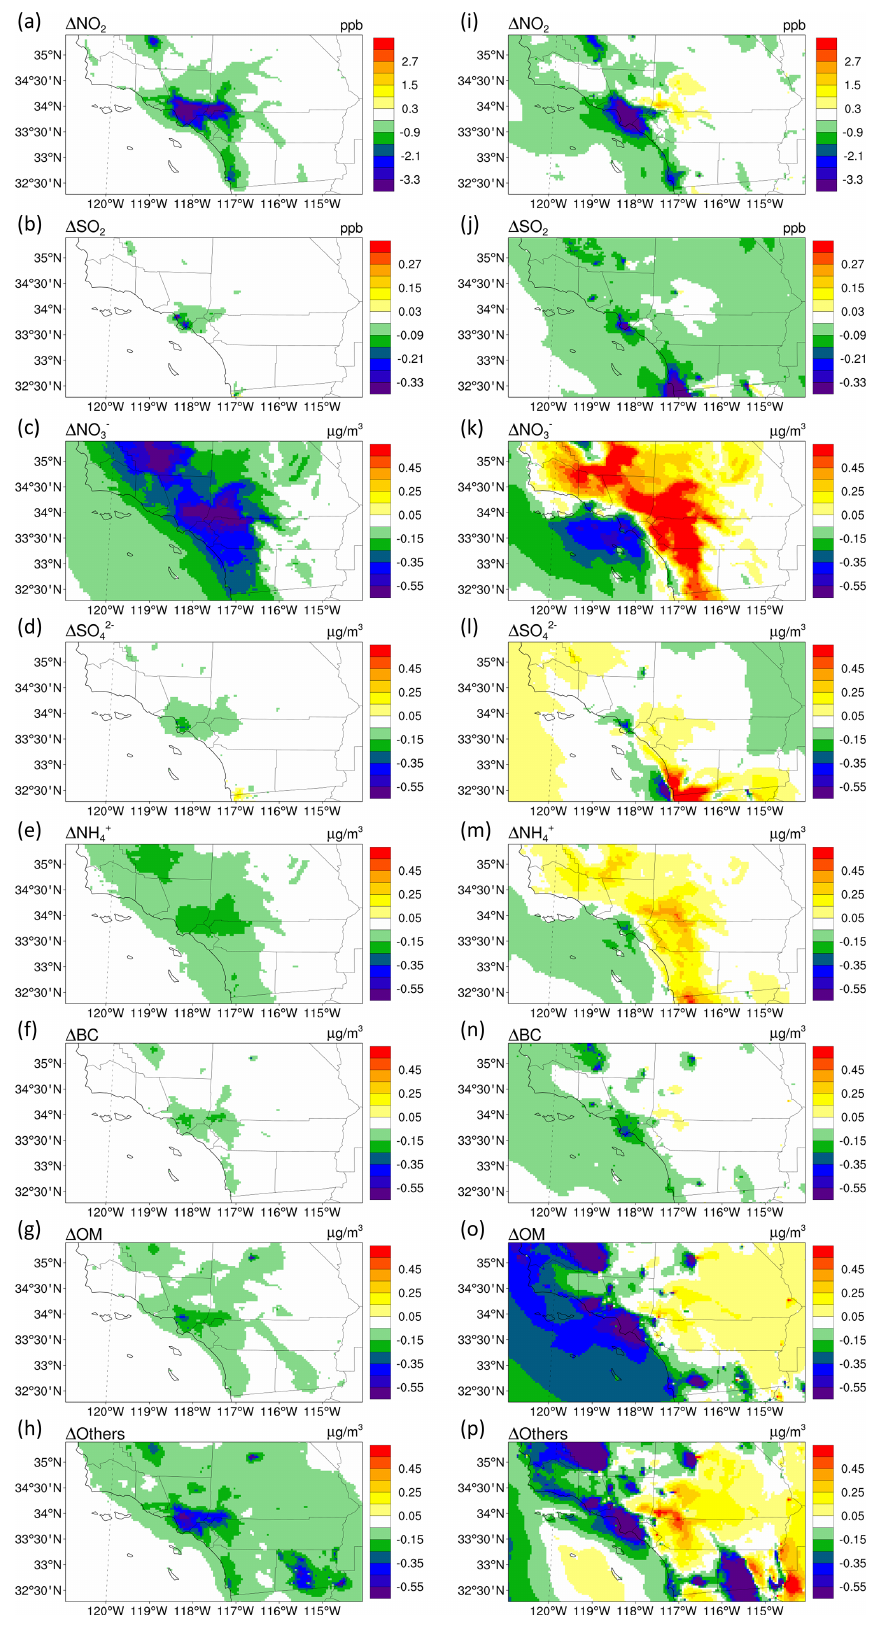
Figure 7. The same as Fig. 6 but for NO 2 , SO 2 , and different PM 2 . 5 chemical components. Atmos. Chem. Phys., 21, 8693–8708, 2021